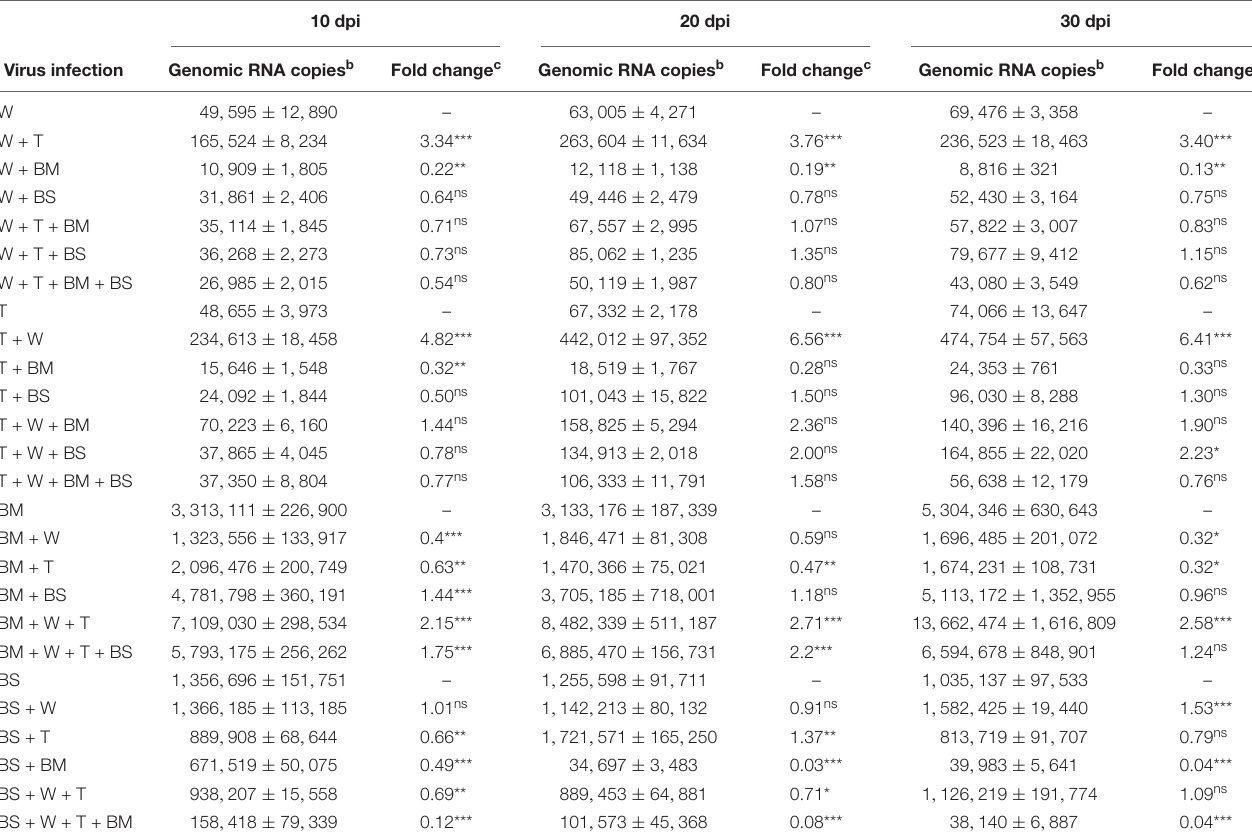
TABLE 1 | Absolute quantification of genomic RNA copies of wheat streak mosaic virus (WSMV), Triticum mosaic virus (TriMV), brome mosaic virus (BMV), and barley stripe mosaic virus (BSMV) in single, double, triple, and quadruple infections in wheat a . 10 dpi 20